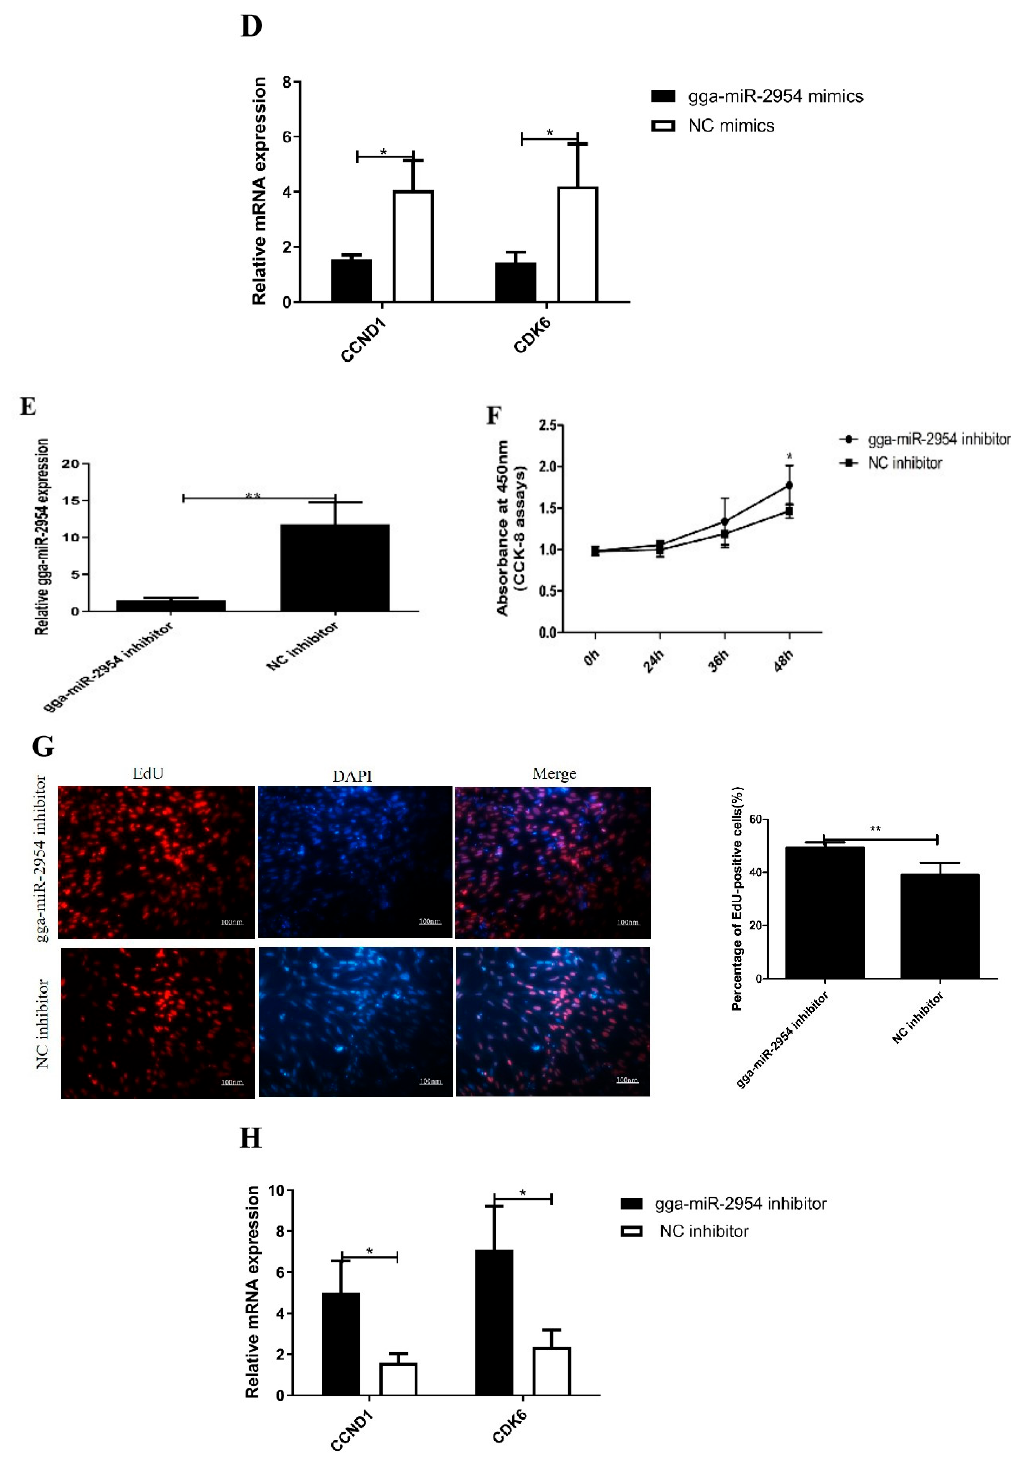
Figure 3. Gga-miR-2954 suppresses myoblast proliferation. ( A ) The overexpression efficiency of gga-miR-2954 after transfection of mimics. ( B ) Cell proliferation rate after gga-miR-2954 overexpression detected by CCK-8. ( C ) EdU cell viability test after gga-miR-2954. overexpression. Scale bar = 100 µ m. ( D ) The mRNA expression of CCND1 and CDK6 after transfection of gga-miR-2954 and NC mimics. ( E ) The expression of gga-miR-2954 after its inhibitor transfection. ( F ) Cell proliferation rate after gga-miR-2954 and NC inhibitor transfection detected by CCK-8. ( G ) EdU cell viability test after transfection of gga-miR-2954 inhibitor and NC inhibitor. ( H ) The mRNA expression of CCND1 and CDK6 after transfection of gga-miR-2954 inhibitor and NC inhibitor. All values were presented as the mean ± SEM from at least three independent experiments (* p < 0.05; ** p <